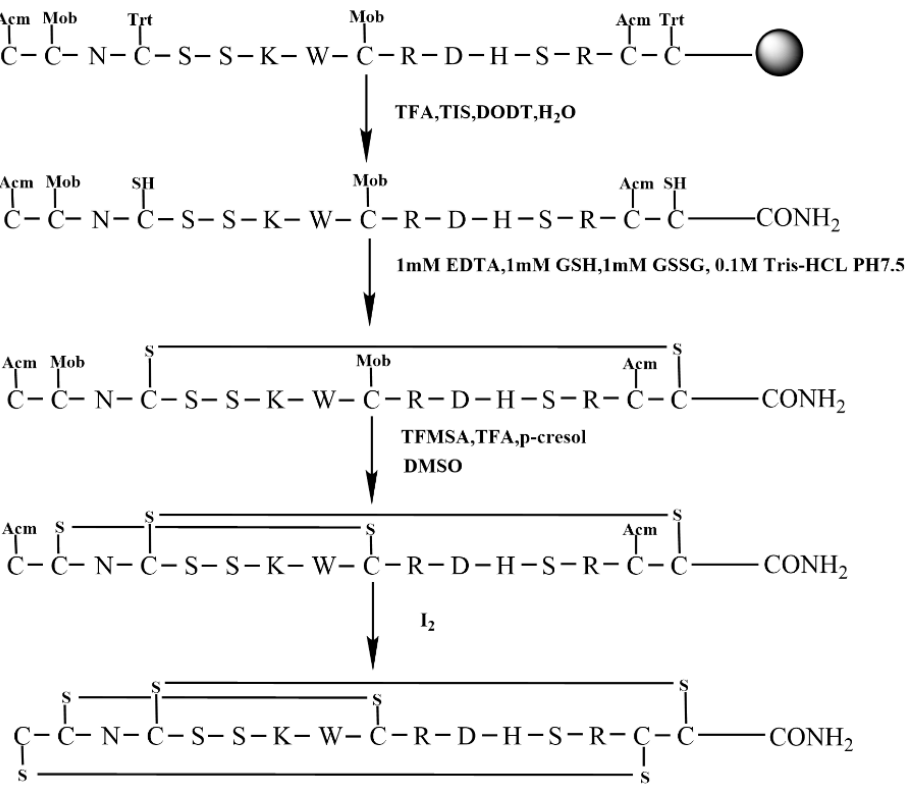
Figure 8. The scheme of regioselective oxidative folding of KIIIA with Acm/Mob/Trt orthogonal Cys protection. (Scheme 4).